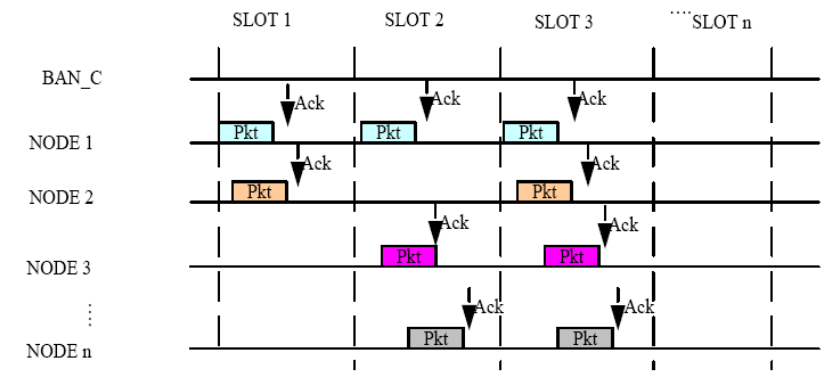
Figure 4. Diagram of transmission between BAN_C and nodes acquisition signal